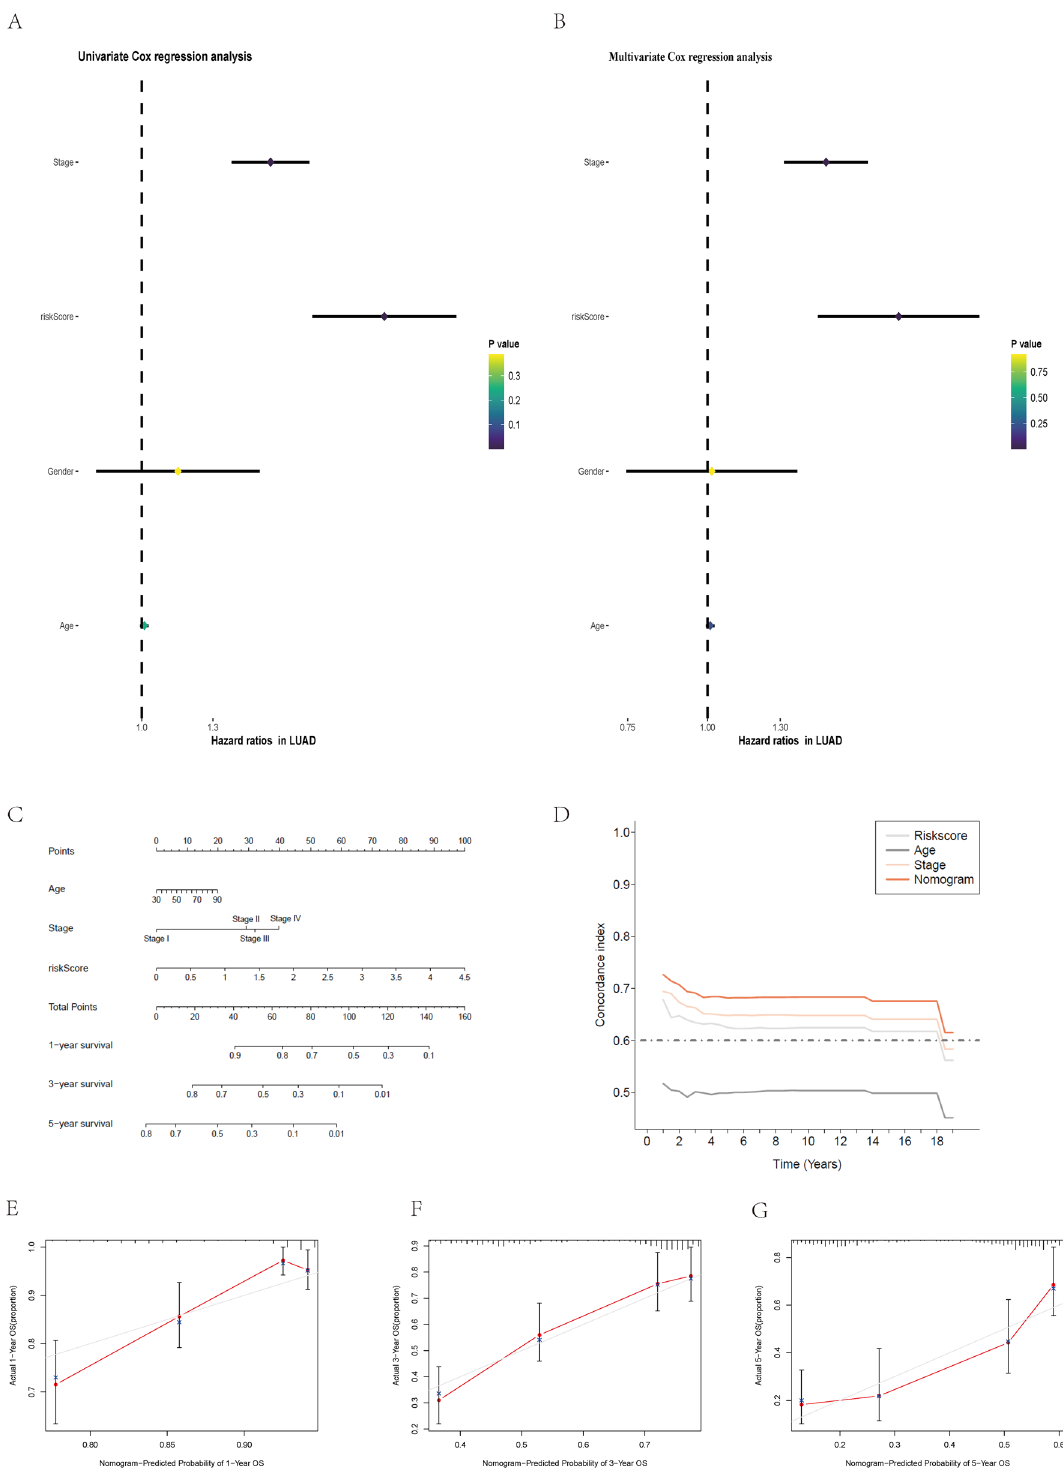
Figure 7. Assessment of the prognostic risk model and clinical characteristics in the entire cohort; construction and evaluation of a prognostic nomogram. ( A , B ) Univariate and multivariate analyses of the clinical characteristics and risk level with OS. ( C ) The nomogram predicts the probability of 1-, 3-, and 5-year OS. ( D ) Concordance indices of the risk score and clinical characteristics. ( E – G ) The nomogram’s calibration plot predicts the probability of 1-, 3-, and 5-year